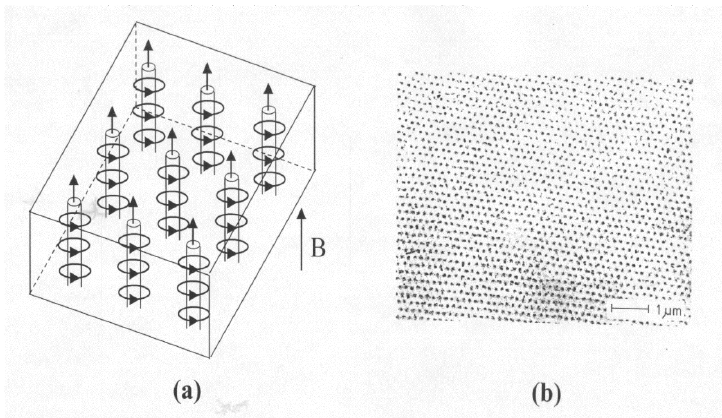
Figure 3. Abrikosov vortex lattice: ( a ) Schematics of nine magnetic flux lines generated by circular supercurrents around them. ( b ) Bitter pattern of the vortex lattice obtained in the case of a superconducting niobium plate of 0.5 mm thickness. The dark spots mark the locations at which the individual magnetic flux quanta reach the surface of the niobium plate. (U.